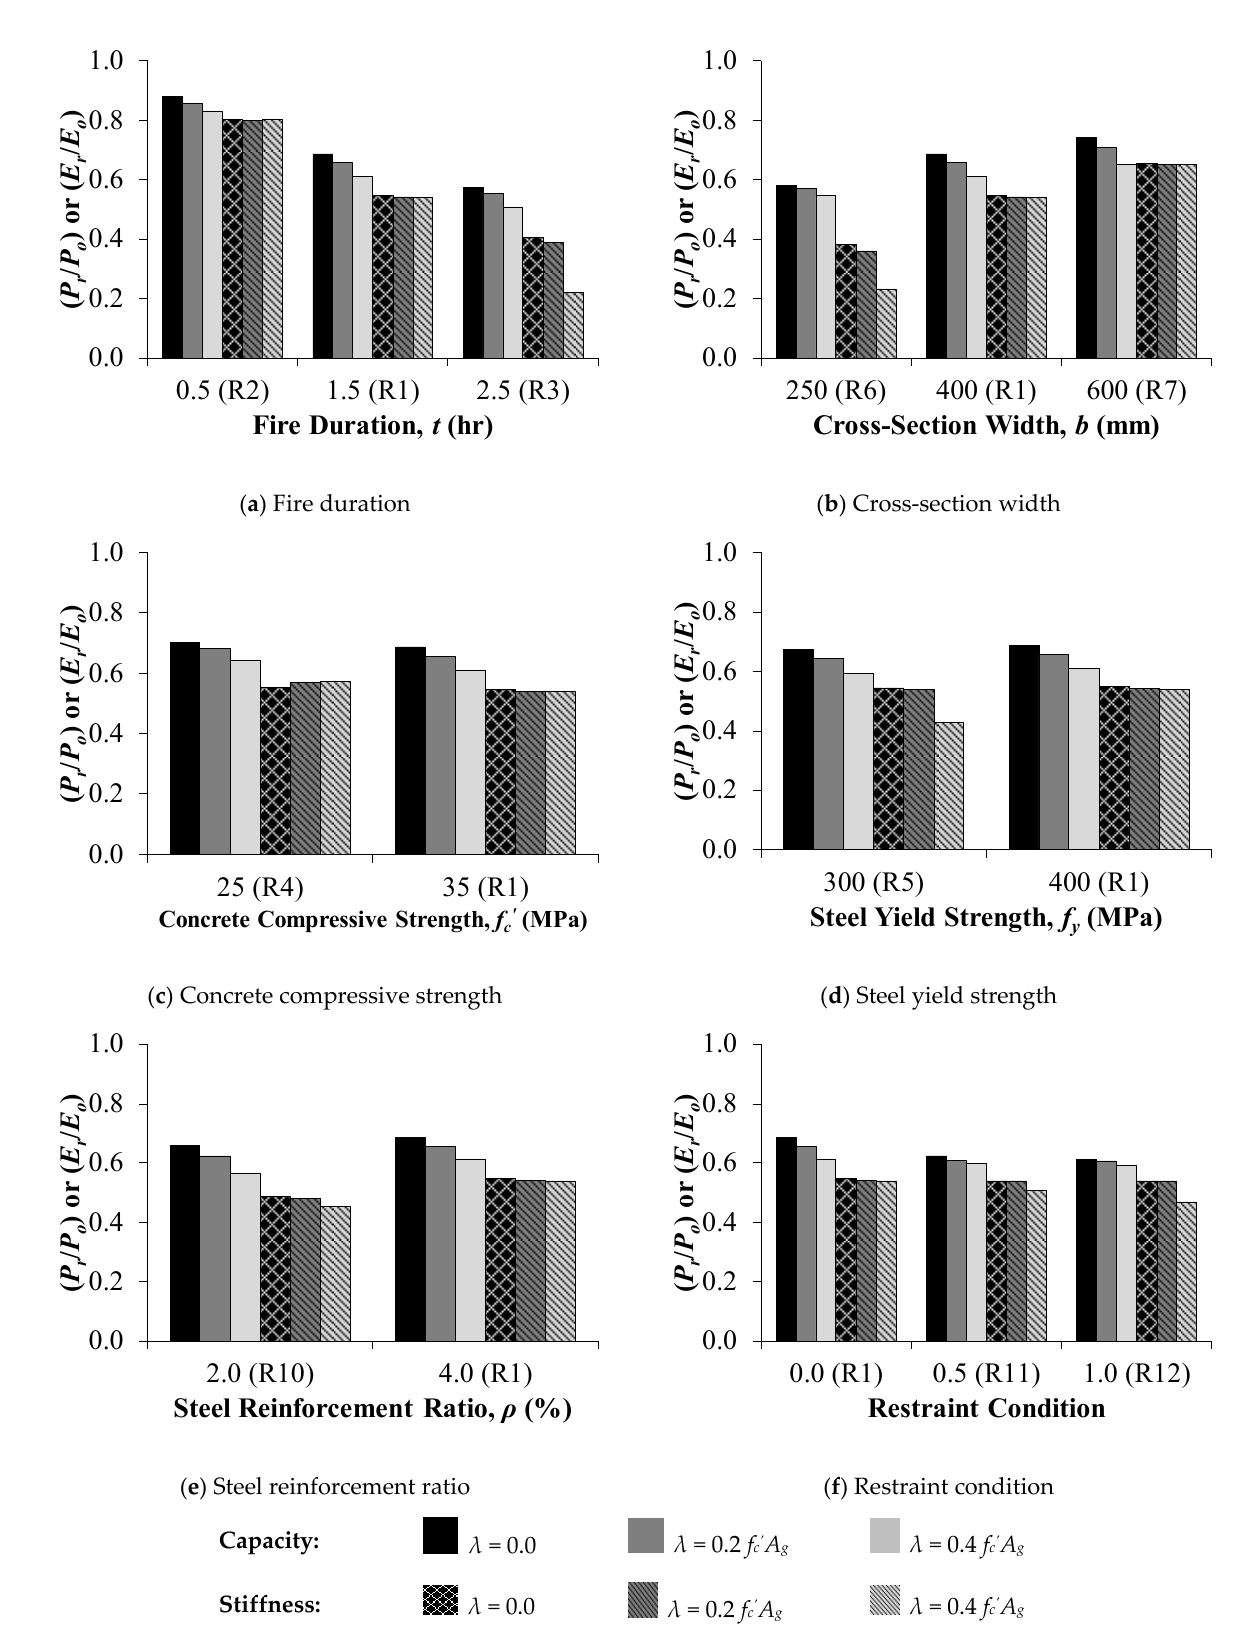
Figure 13. Influence of varying the examined parameters on the axial capacity and stiffness of rectangular columns.